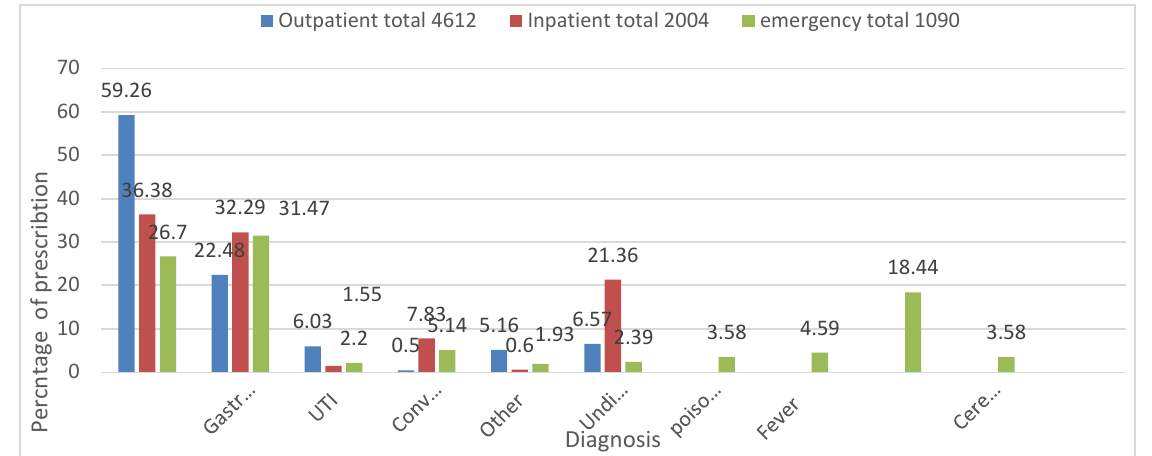
Figure 10: Indications for antibiotics in different department (Total 7706).